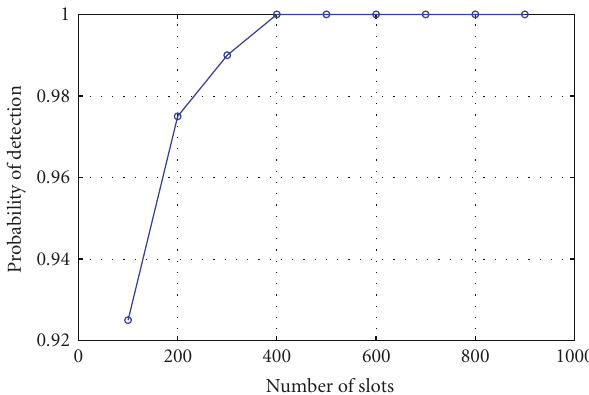
Figure 11: Probability of detection versus v for SNR = 10dB, N SLOT = 500, and K 0 = 10.